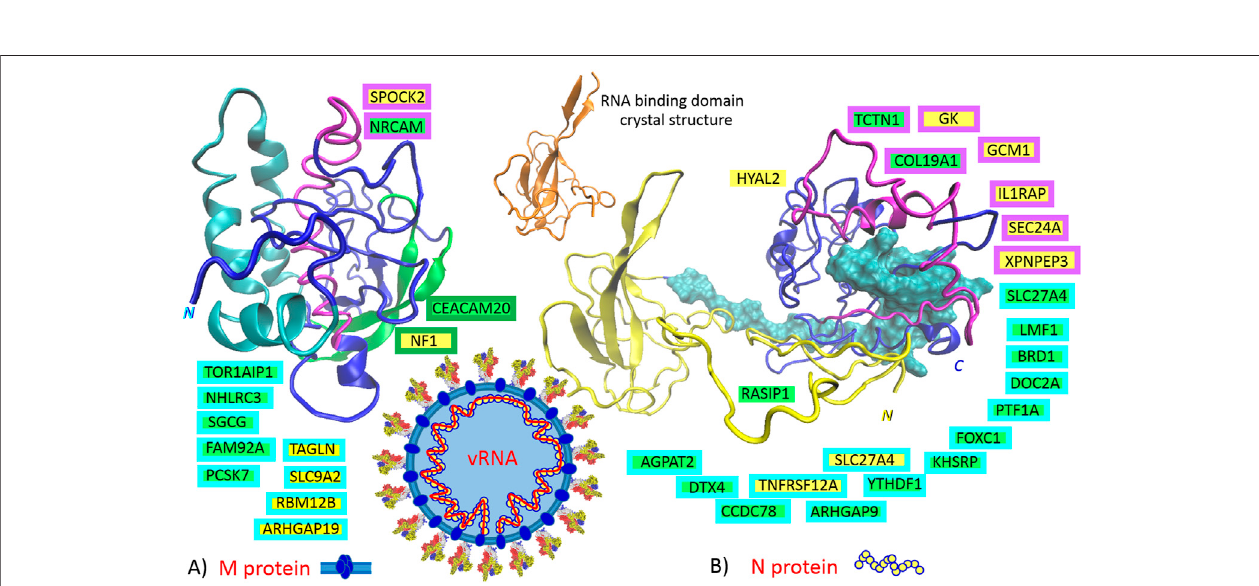
FIGURE 3 | The identi fi ed sequences in QHD43419 (A., membrane protein: M) and QHD43423 (B., capsid protein: N). Green highlights show the alignments with the complement sequence (post-transcriptionally repressed); yellow highlights show the alignments with the reverse complement sequence (post-transcriptionally promoted). Thepositioninthe3Dstructuremodels(https://zhanglab.ccmb.med.umich.edu/COVID-19/) iscoloredinthesame colorastheframeofthegene.6M3M, N protein, crystal structure of RNA binding domain (range: 50 – 174), (Kang et al., 2020).